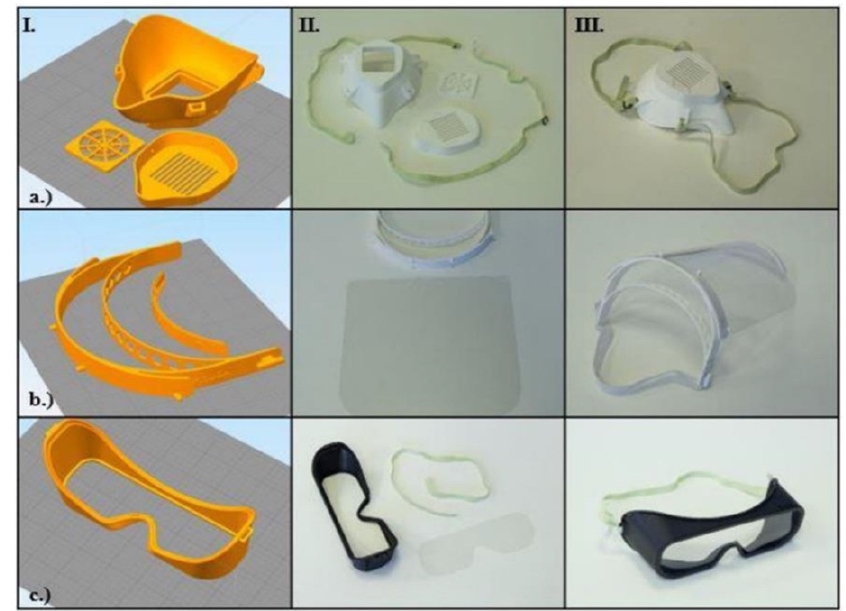
Figure 1. Overview of personal protective equipment (PPE) manufacturing process using 3D printing. With Column I—demonstrating CAD assembly, II—3D printed parts, III—the assembled models. The rows show ( a ) a respirator face mask; ( b ) a face shield; ( c ) a pair of safety googles. This image is reprinted under a Creative Commons Attribution 4.0 International License and it is taken from [18].